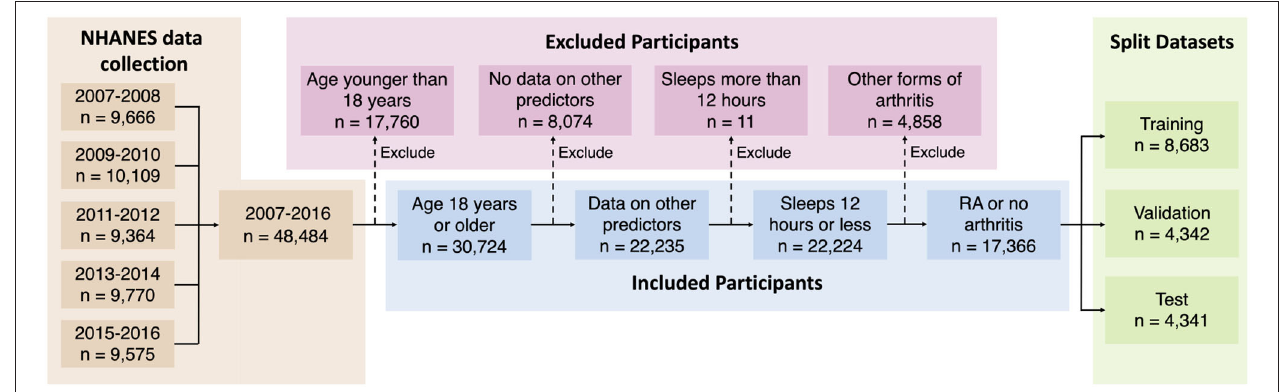
FIGURE 2 | Selection of study